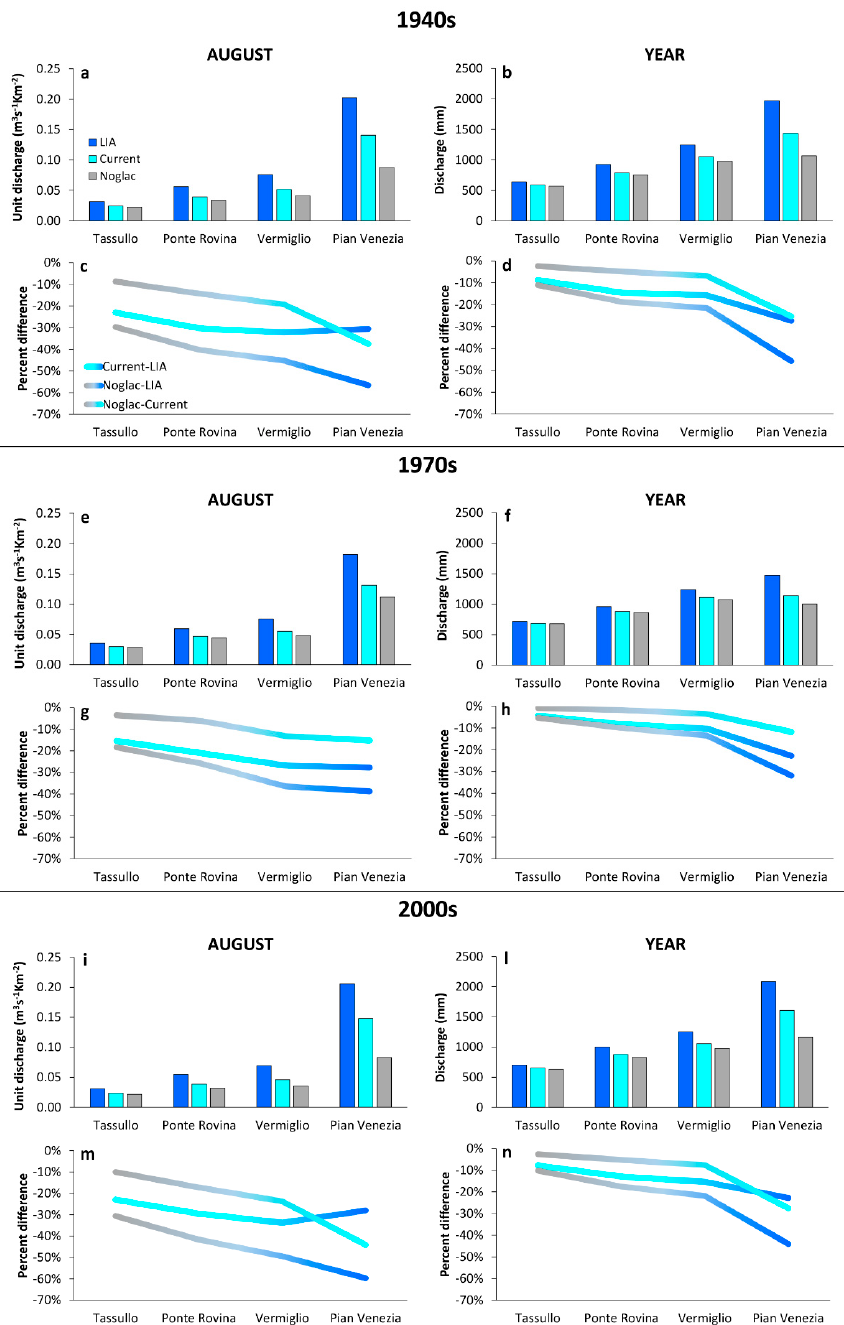
Figure 7. Comparison of median unit discharge in August ( left column ) and of annual runoff ( right column ) obtained with different glacier extents and in different meteorological periods.